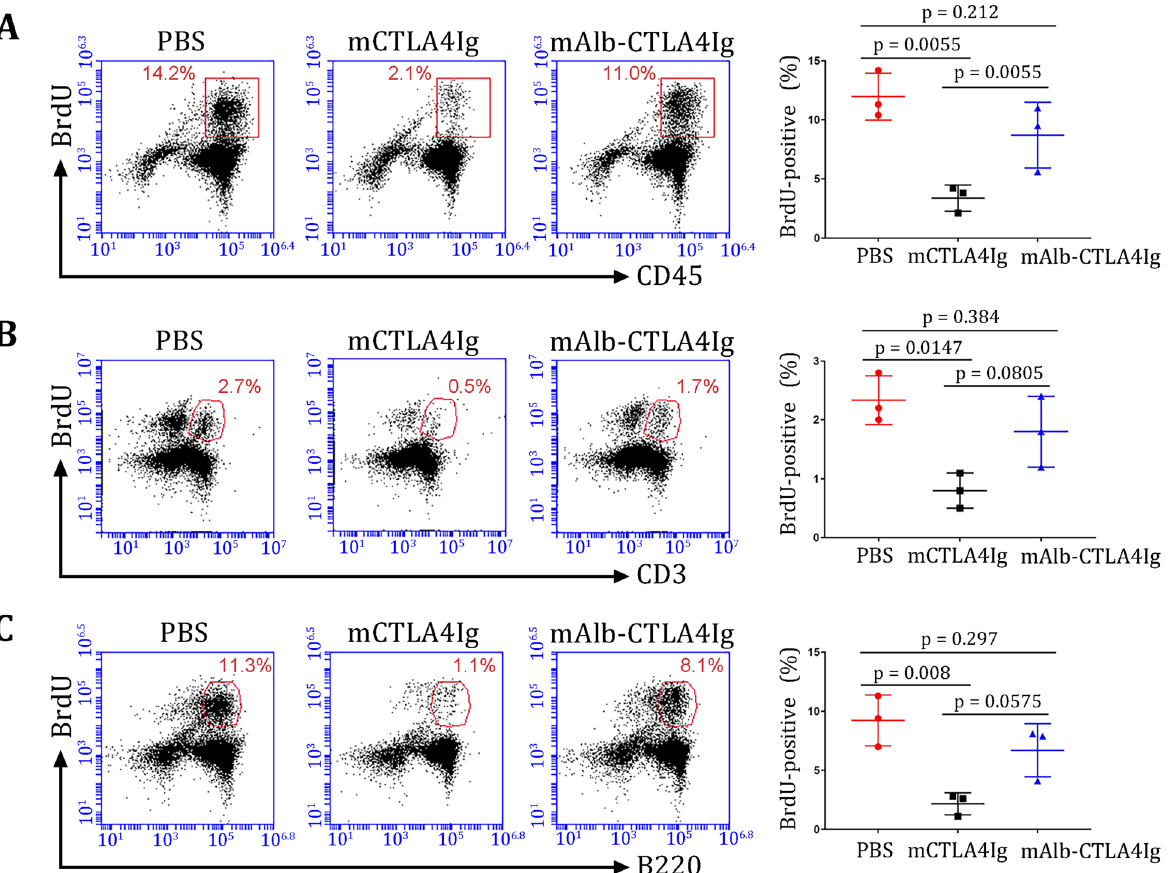
Fig. 8 Safety of Alb‑CTLA4Ig. Splenocytes from PBS‑, mCTLA4Ig‑, or mAlb‑CTLA4Ig‑treated CIA mice were stimulated with 25 μg/ml M. tuberculosis extracts for 72 h. Proliferation (BrdU incorporation) of CD45 + splenocytes ( A ), CD3 + T cells ( B ), and B220 + B cells ( C ) was analyzed by flow cytometry. Representative data from two independent experiments are